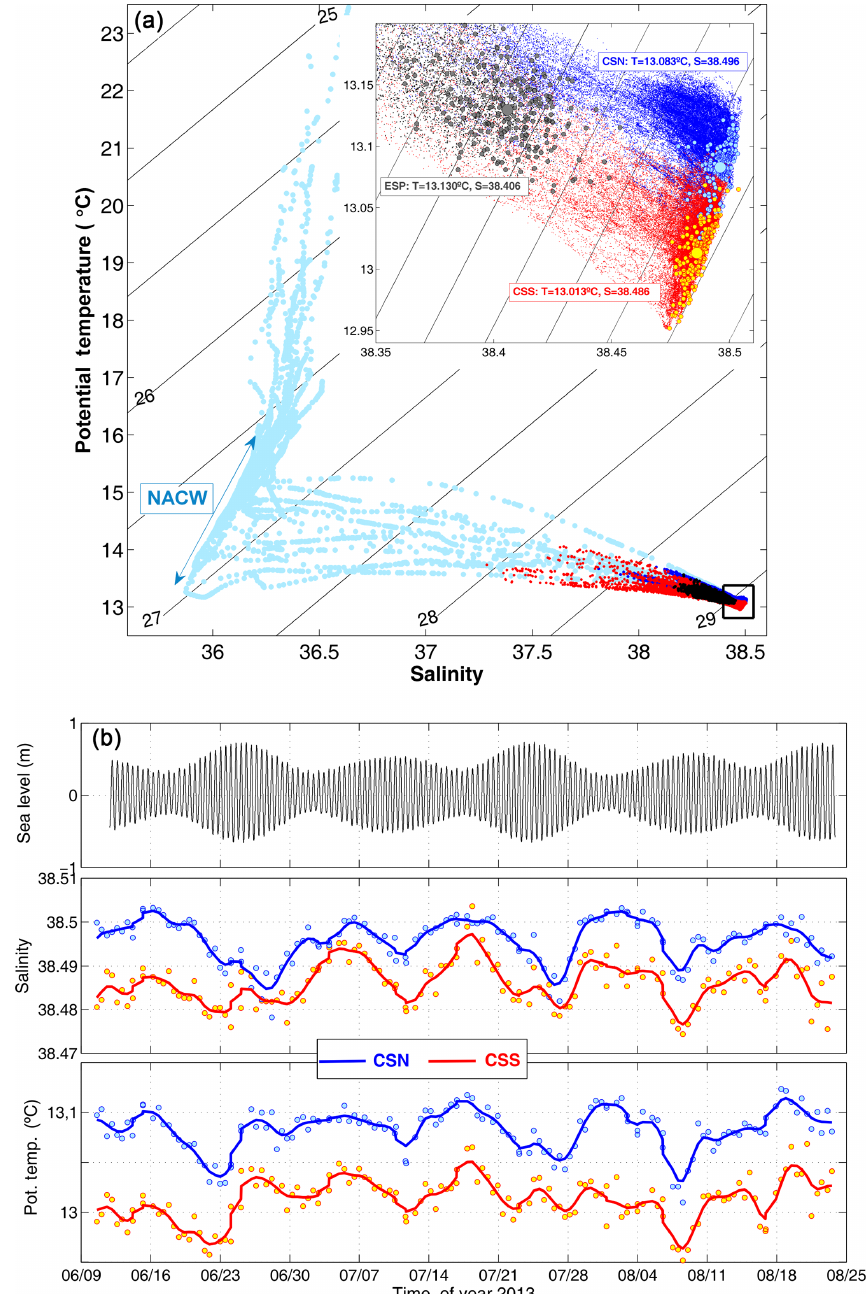
Figure 4. (a) T − S diagram of all samples recorded at CSN (blue), CSS (red), and ESP (black). Historical CTD casts collected at ESP site are displayed in light-blue dots. The typical linear temperature–salinity relationship is sketched by the double-headed arrow. The inset zooms on the area inside the black rectangle to show the subset of maximum density samples at each site (filled circles with the same colour code). Large filled circles indicate the mean values, which are also specified in the text boxes. (b) Time evolution of potential temperature and salinity of the subset of maximum density (coloured dots) and a 2-day low-pass-filtered version of them (solid lines). Top panel is the sea level at Tarifa, which is included to illustrate the fortnightly cycle of the variables, more visible in the salinity